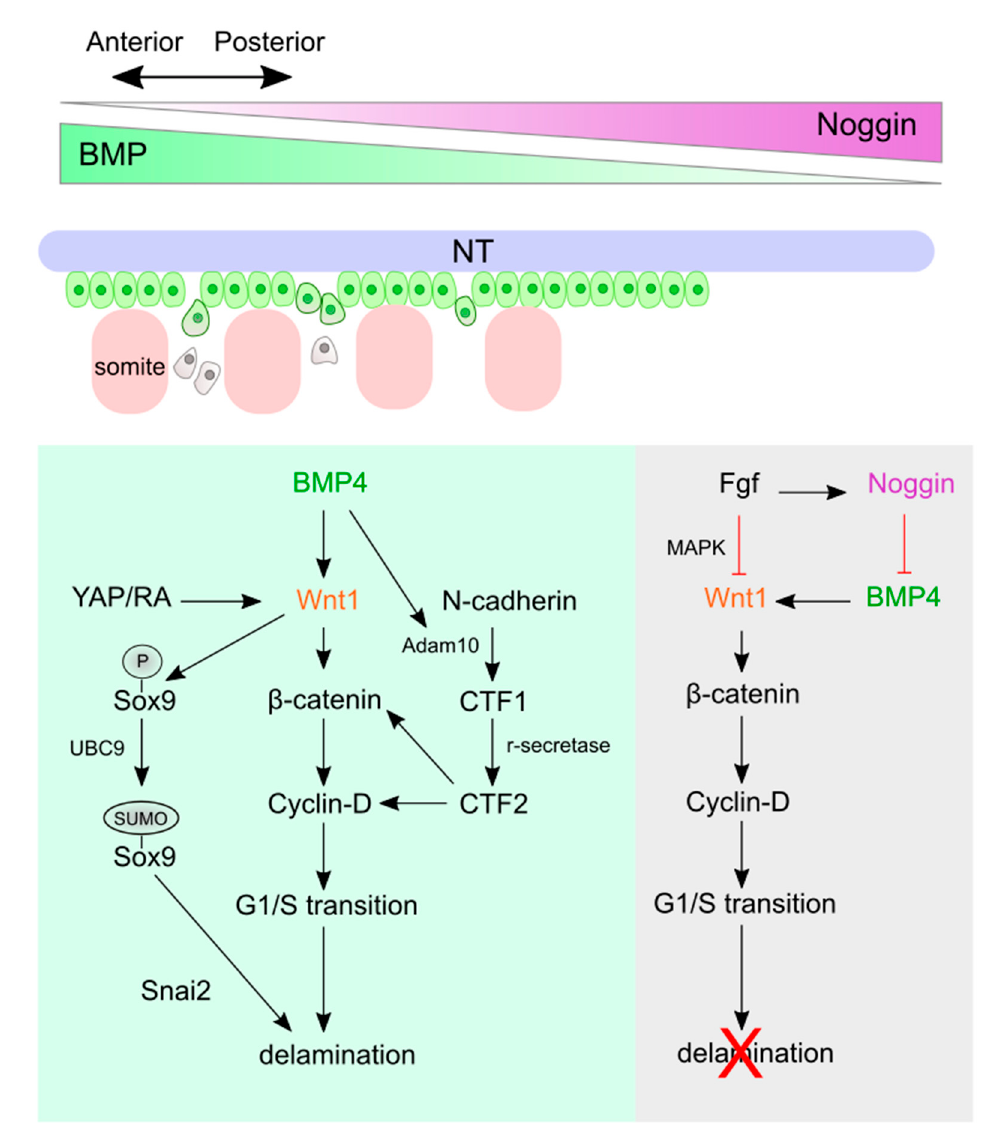
Figure 4. Bmp / Wnt signaling regulates trunk neural crest cell delamination. Undefined factors from somites inhibit Noggin ( purple ) expression anteriorly, creating a gradient Bmp ( green ) activity with a high level in anterior and low level in posterior of the dorsal neural tube. Bmp4, Yap, and RA signaling induce canonical Wnt1 expression, leading to Cyclin D1 transcription and G1 / S transition to promote NC cell emigration. However, at the segmental plate mesoderm at the posterior region, Fgf signaling maintains high levels of Noggin that inhibits Bmp activity. Low Bmp activity blocks Wnt signaling, which prevents NC cell delamination from the caudal neural tube.